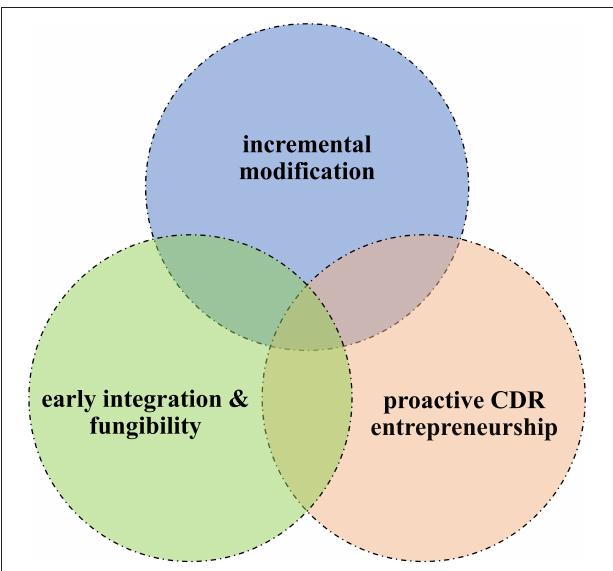
FIGURE 1 | Three types of integrating CDR into climate